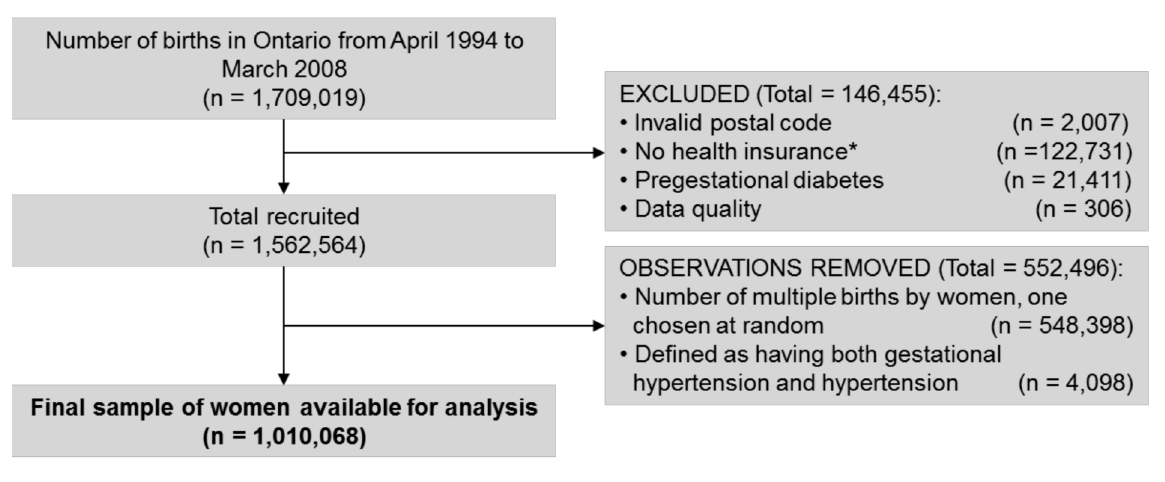
Figure 1. Cohort flow chart illustrating the inclusion and exclusion of participants into the study. *Mothers either lacked coverage under Ontario’s Health Insurance Plan at the admission delivery date or had health insurance for less than 2 y prior to their delivery.